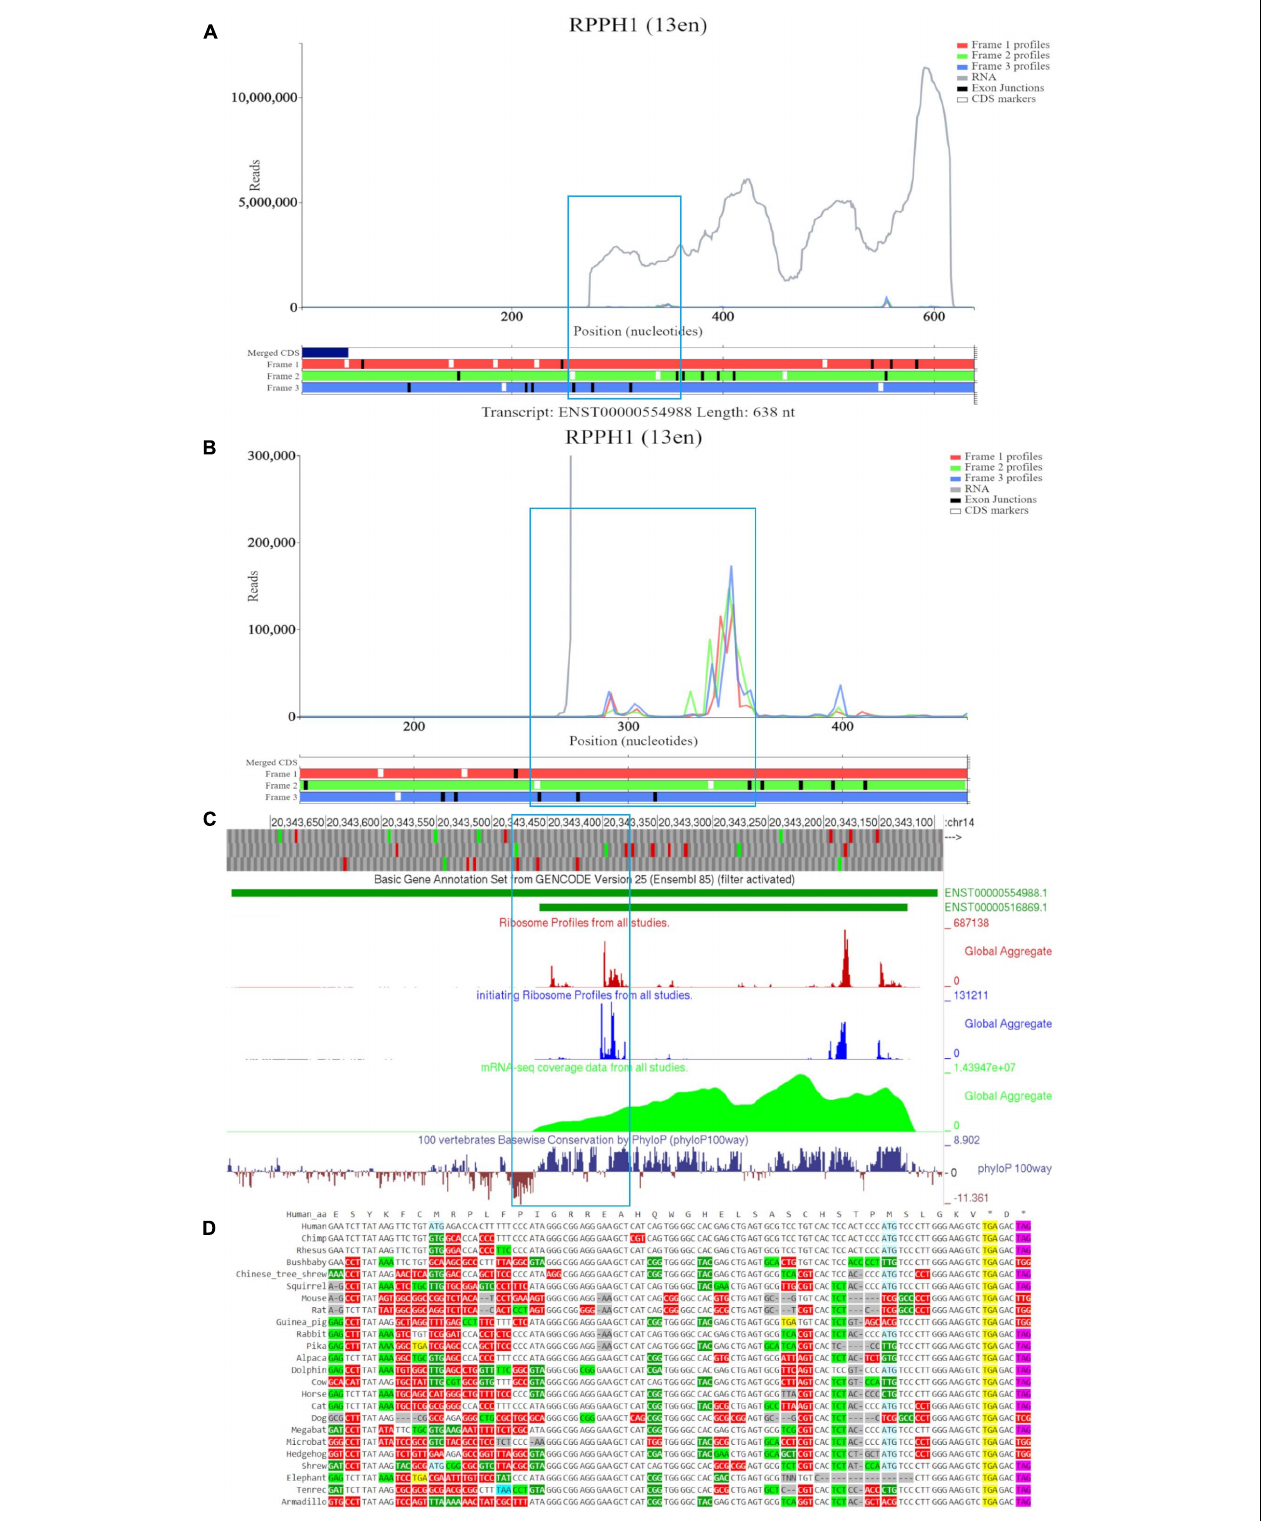
FIGURE 3 | Visualization of RPPH1 in Trips-Viz, GWIPS-Viz and CodAlignView. (A) Whole transcript view of RPPH1 in Trips-Viz with the ORF outlined in blue. (B) Enlarged view of the ORF on RPPH1 in Trips-Viz (C) Visualization of the RPPH1 in GWIPS-viz with the tracks described in Setup and Configurations enabled. (D) CodAlignView of the ORF on RPPH1 showing predominantly absolute codon conservation.